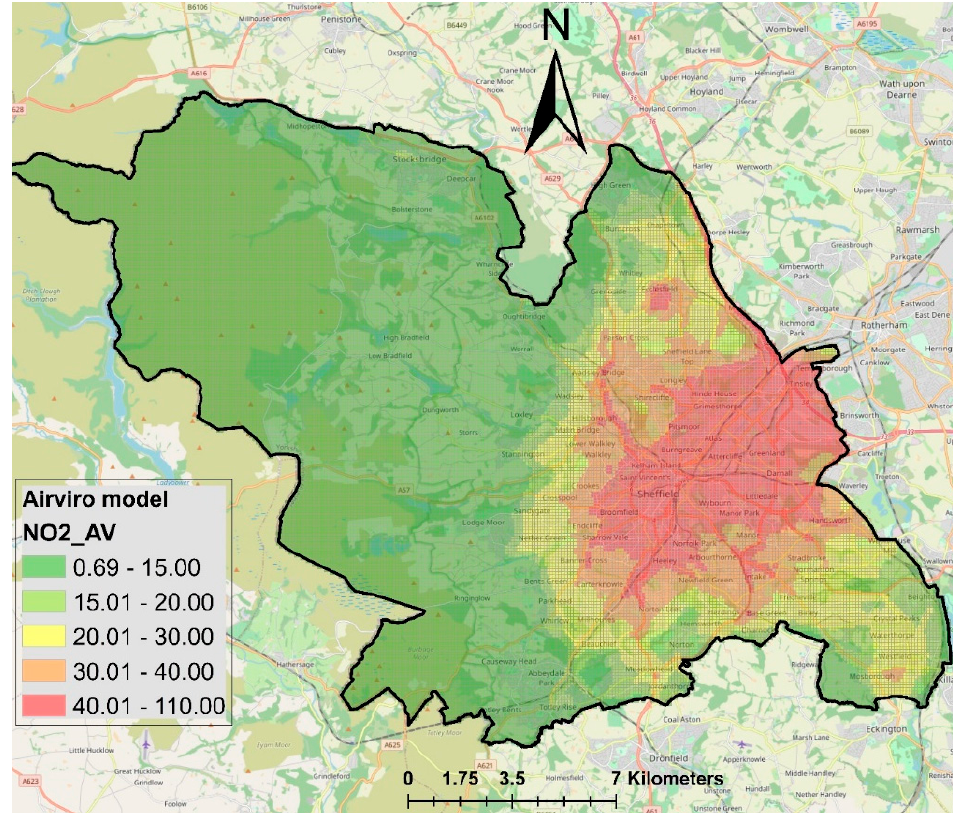
Figure 2. Spatial variability of annual mean modelled NO 2 in Sheffield. Maps were developed using Airviro model (modified from [13]).